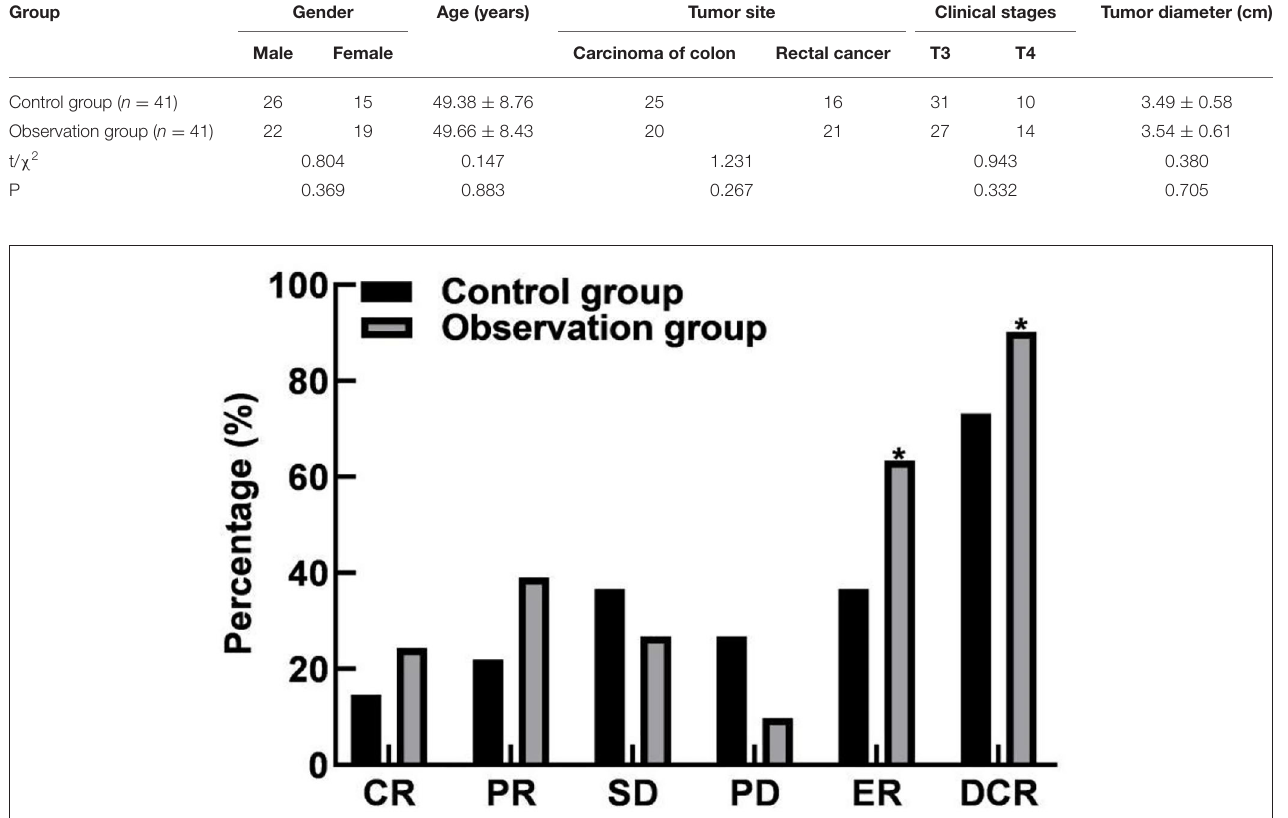
FIGURE 1 | Comparison of efficacy between the two groups. Compared with the control group, * P <